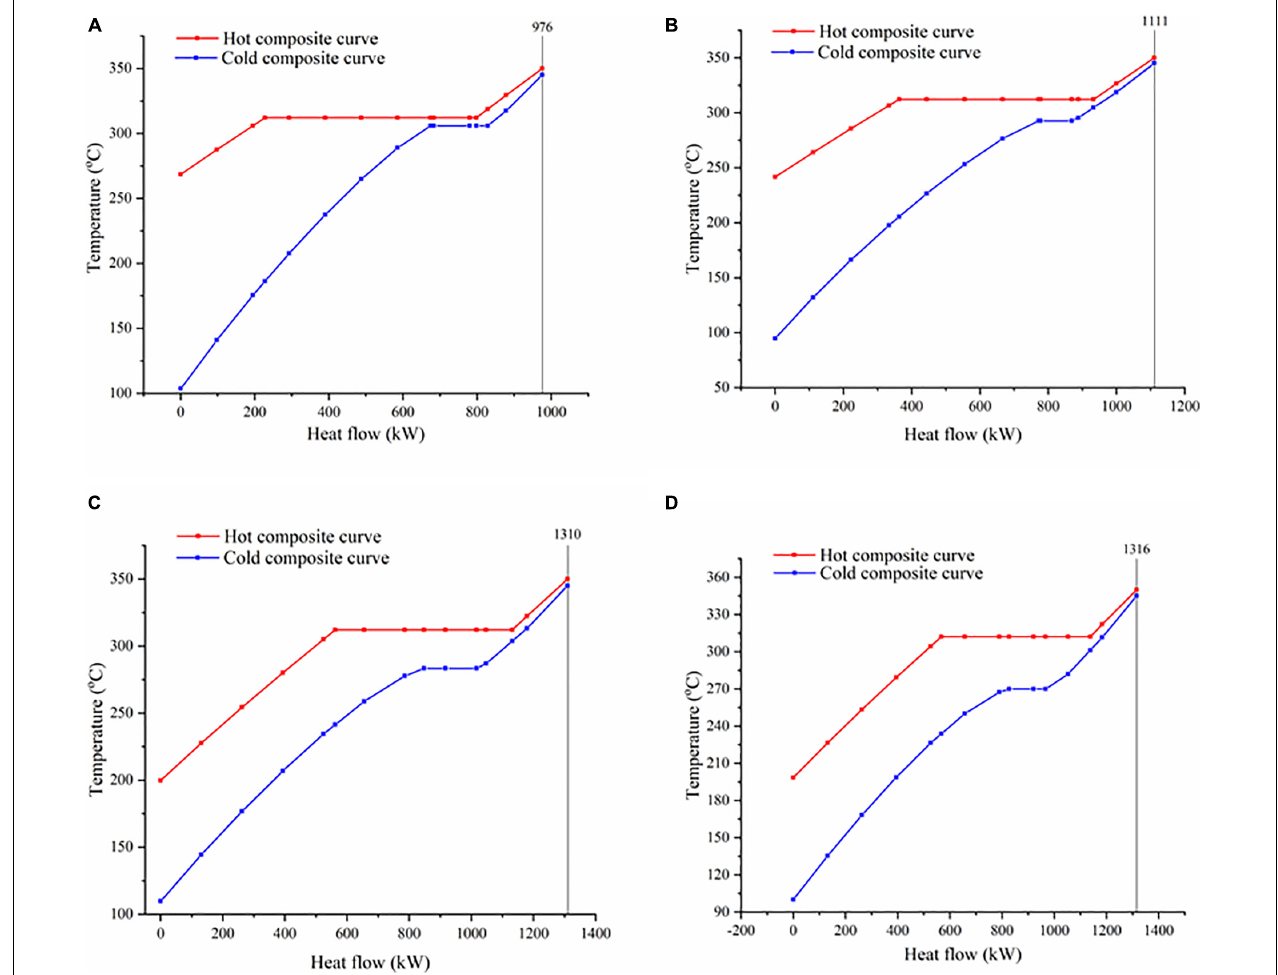
FIGURE 4 | Temperature–heat flow composite curves of organic Rankine systems using (A) toluene, (B) methylcyclohexane, (C) n -butanol, (D) i -butanol as working